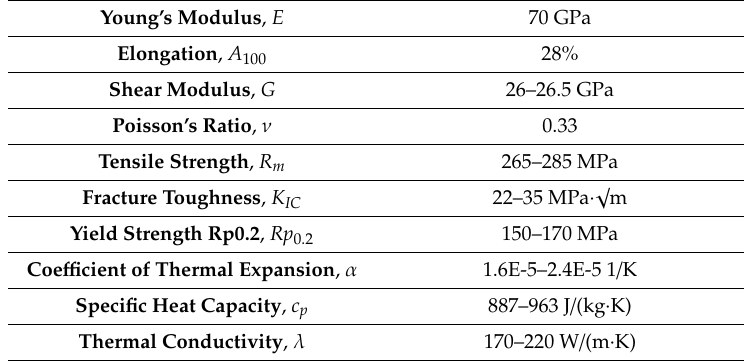
Table 1. Mechanical and thermal properties of AA6111-T4 aluminum alloy (at T = 20 ◦ C).